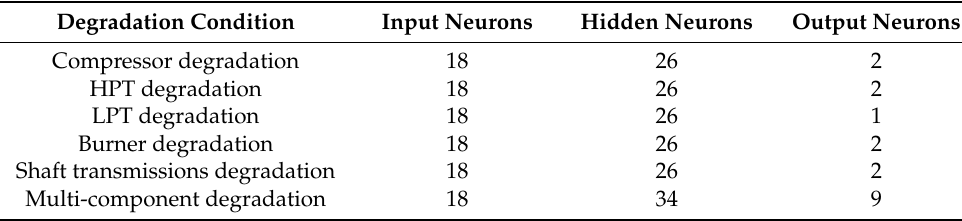
Table 5. Characteristics of neural networks trained with original datasets.